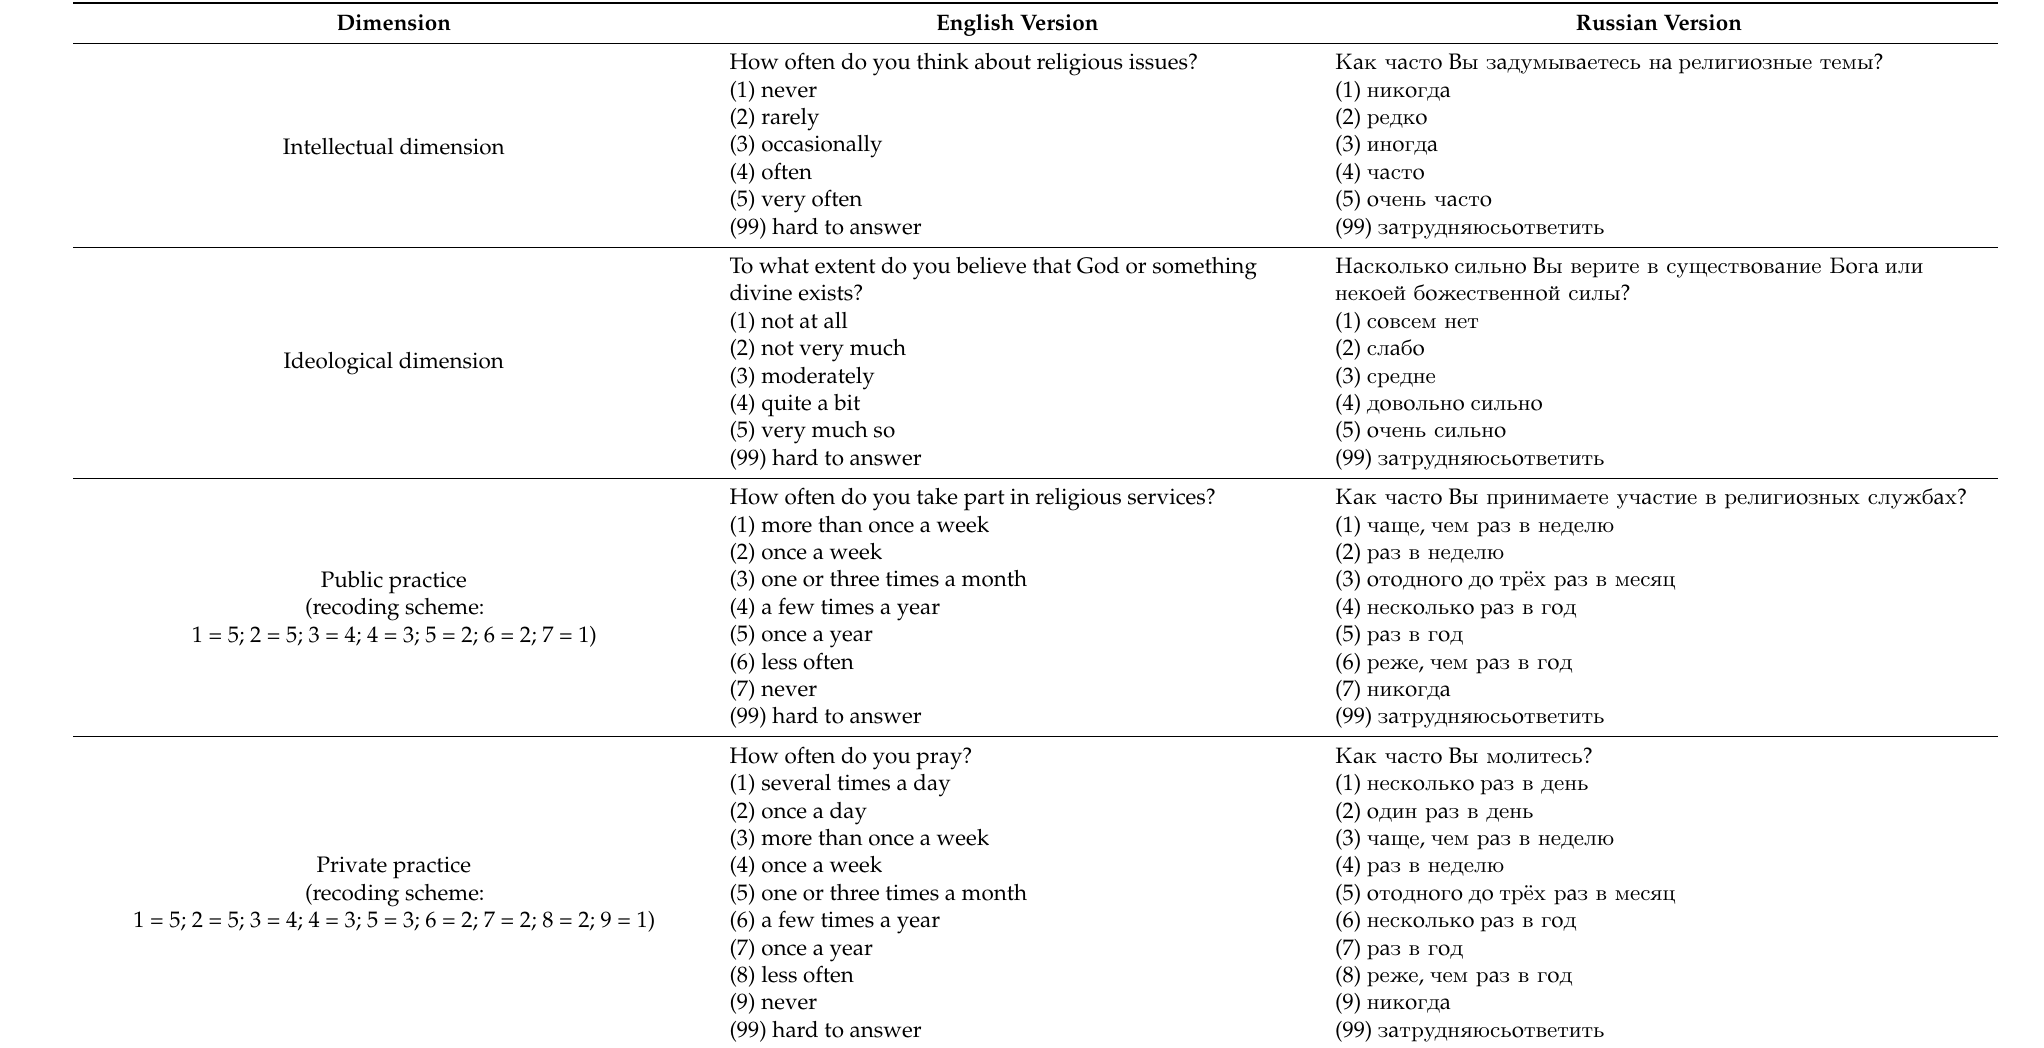
Table 1. Items of the modified Centrality of Religiosity Scale (CRS-SOC)—English and Russian versions.